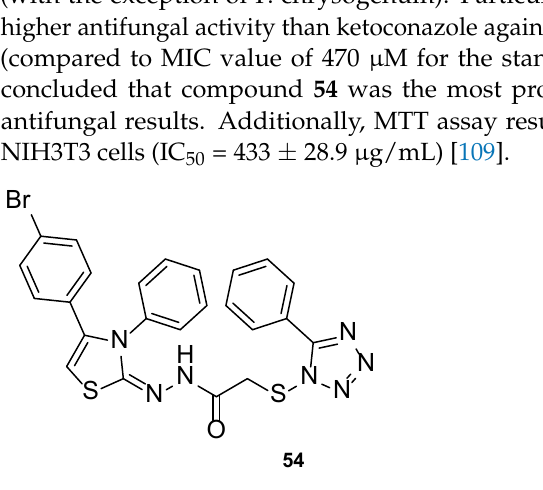
Figure 29. Chemical structure of compound 54 [109].